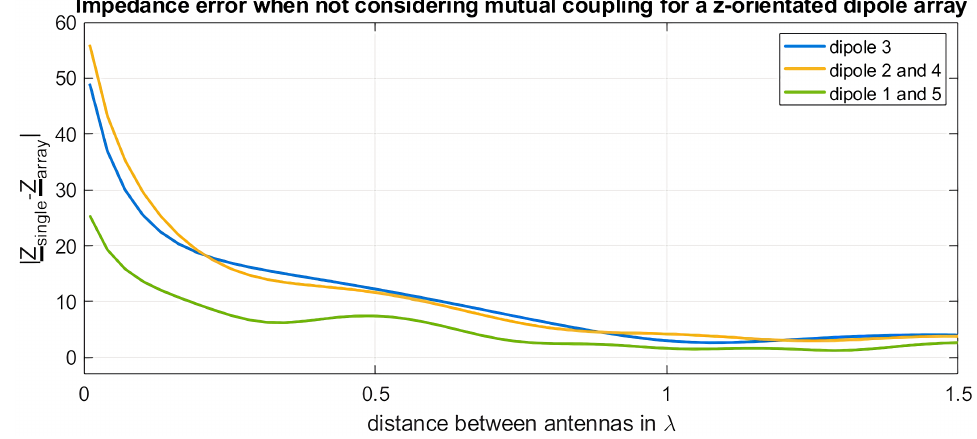
Figure 16. The difference of the impedance between the two computation methods for every dipole as a function of the distance between the array elements in